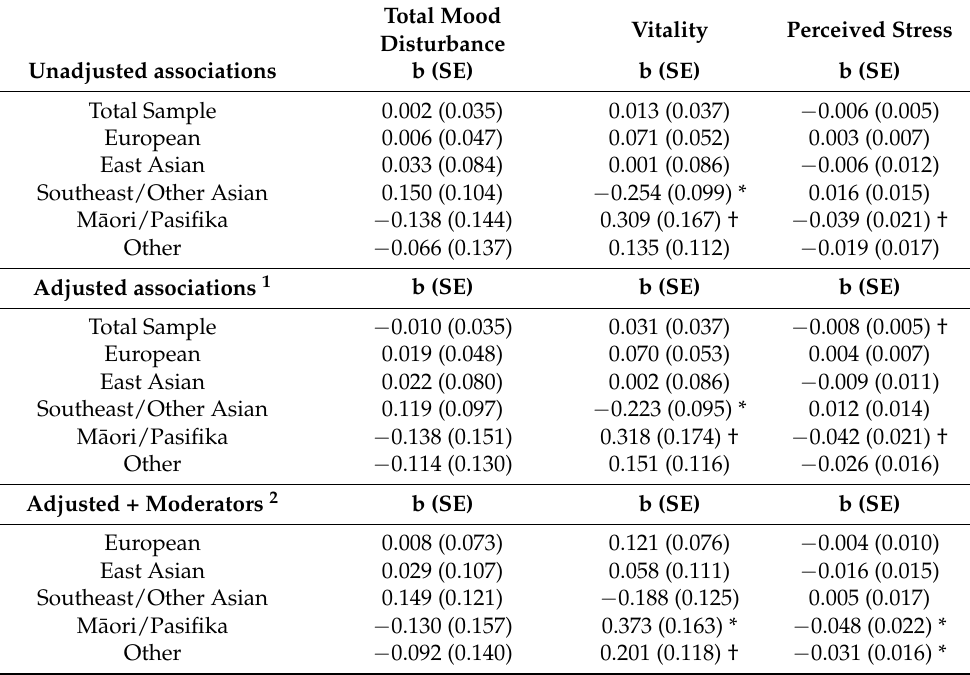
Table 3. Stress for the Total Sample and for Different Ethnicity Groups, Unadjusted for Covariates (top), and Adjusted for Covariates (middle) and Adjusted for Covariates and Moderators (bottom).